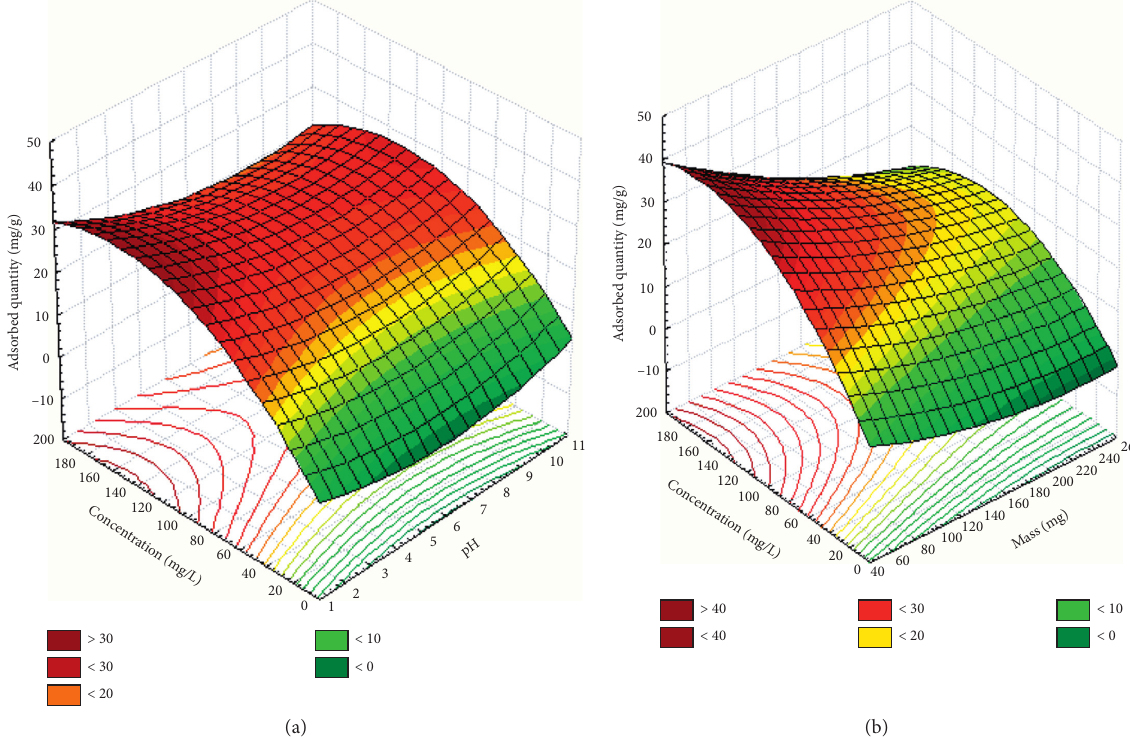
Figure 3: 3D surface plot of the adsorbed quantities of HQ by CAK-S as a function of (a) concentration and pH and (b) concentration and mass.